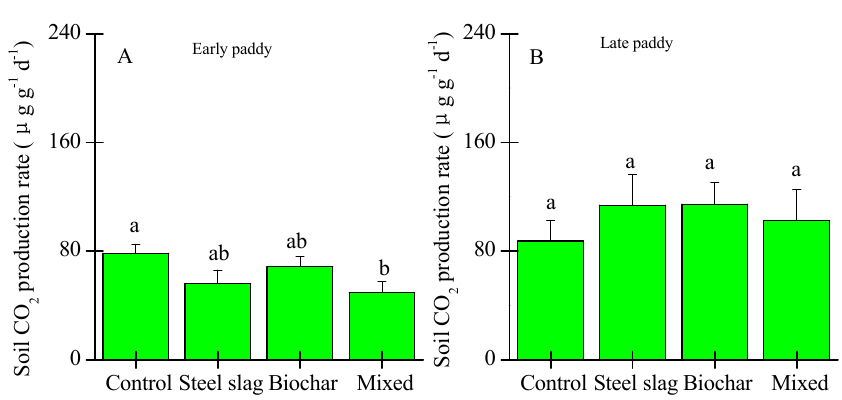
Figure 2. Mean concentrations of SOC ( A , B ), LOC ( C , D ), MBC ( E , F ), and DOC ( G , H ) in the treatment and control plots in the early and late paddy fields. Different letters represent significant difference in mean values among treatments ( p < 0.05, n = 6).